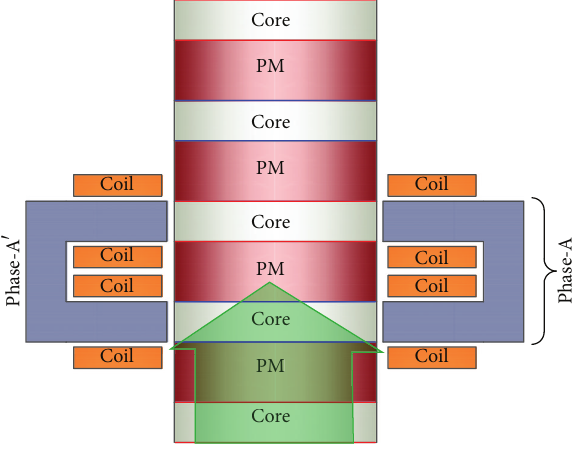
Figure 3: Position of the translator for time 𝑡 2